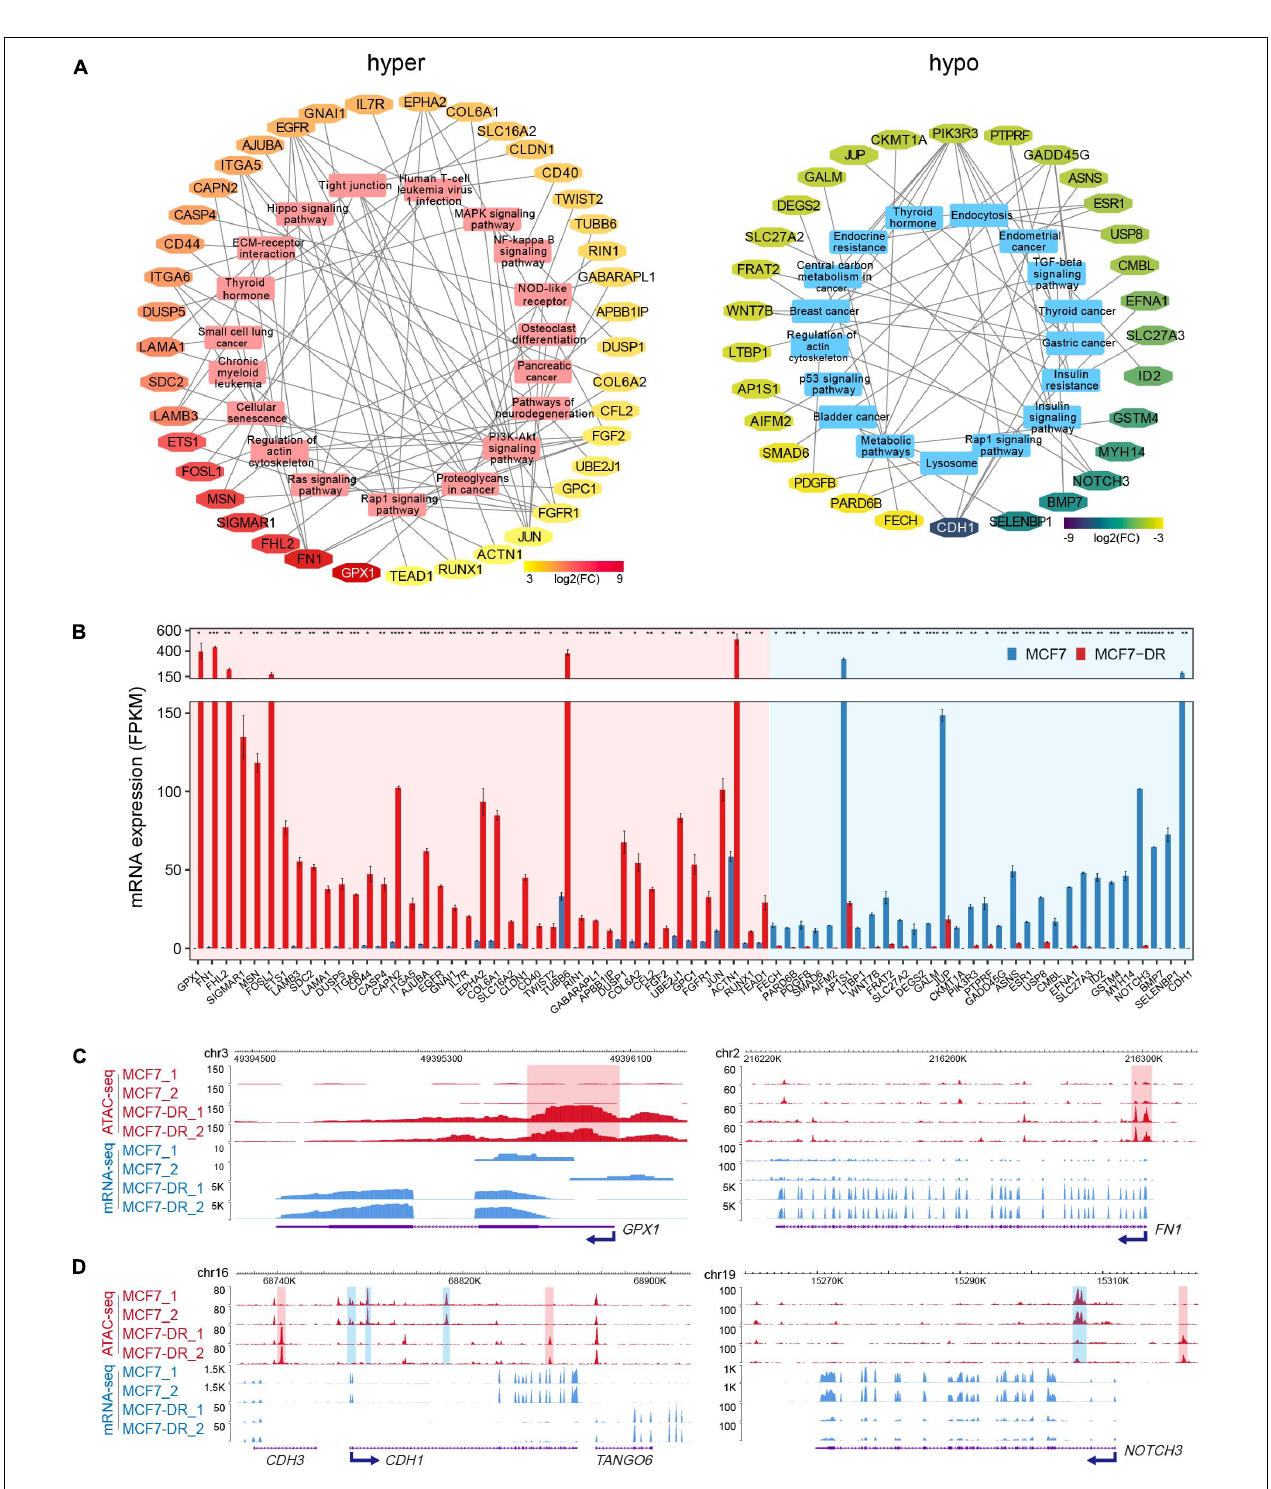
FIGURE 4 | Key KEGG pathways associated DEGs related to DARs. (A) Top 20 KEGG pathways associated DEGs related to hyper- (left) and hypo-accessible (right) regions. DEGs are shown in different colors according to log 2 (FC). (B) Bar plot showing average expression levels (FPKM) of DEGs related to hyper- (red shaded area) and hypo-accessible (blue shaded area) regions which enriched in top 20 KEGG pathways. DEGs are listed in a descending order based on log 2 (FC). The P values were calculated using Student’s t test in R. * P < 0.05, ** P < 0.01, *** P < 0.001, and **** P < 0.0001. (C) The WashU Epigenome Browser tracks show ATAC-seq (red) and mRNA-seq (blue) signals of representative up-regulated GPX1 and FN1 genes. The hyper-accessible regions are shaded with red. (D) Genomic snapshots of ATAC-seq (red) and mRNA-seq (blue) signal of representative down-regulated CDH1 and NOTCH3 genes. The hypo-accessible regions are shaded with blue.